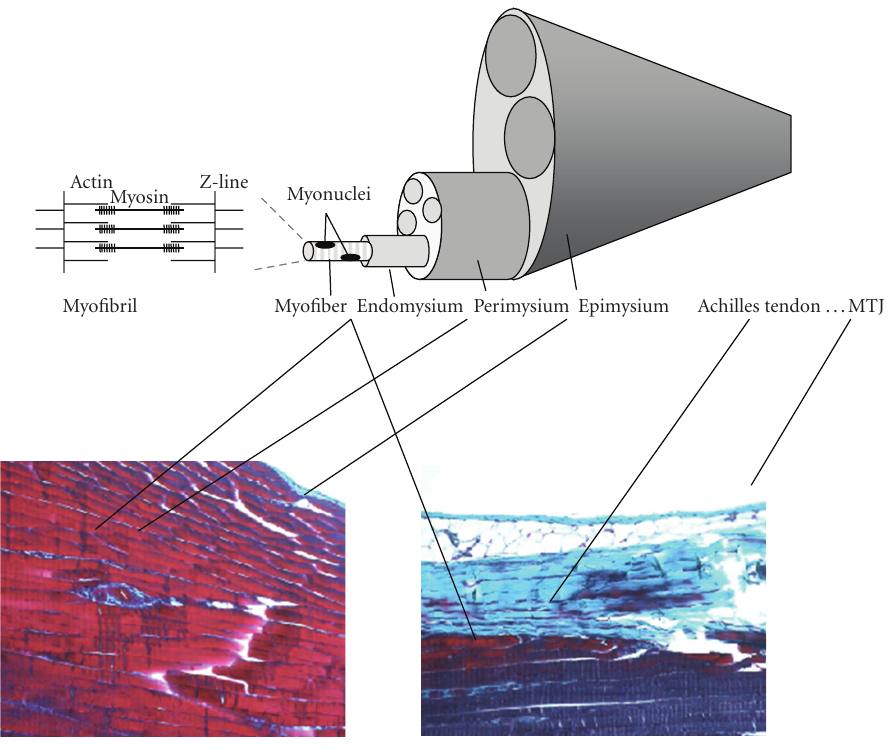
Figure 4: Schematic representation of the skeletal muscle structure and histological images of a longitudinal section of murine skeletal muscle and of murine Achilles tendon myotendinous junction (MTJ) stained with a trichrome Gomori stain to visualise collagenous tissues (staining muscle red, collagenous tissues blue, and nuclei